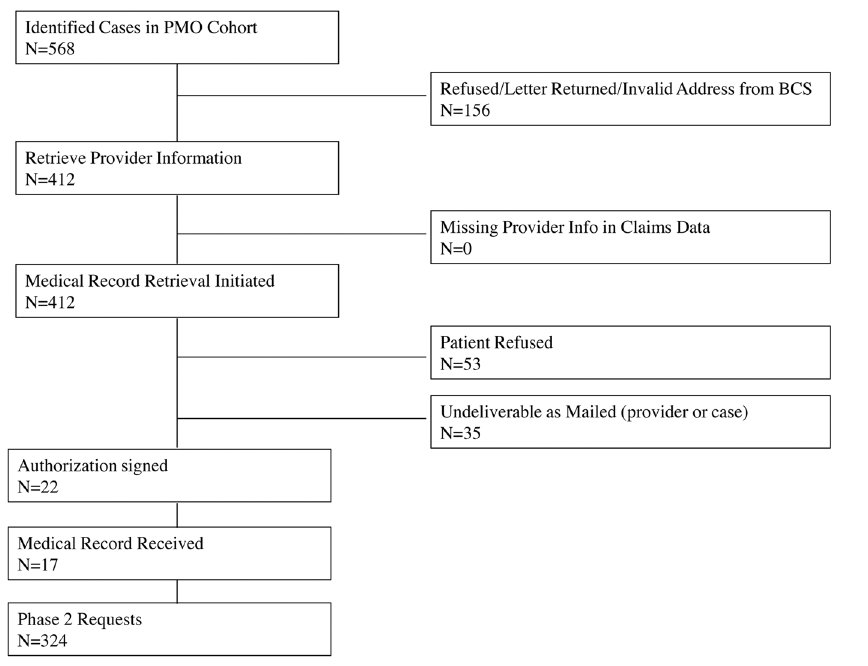
Fig 2. US Medicare Participant Selection —